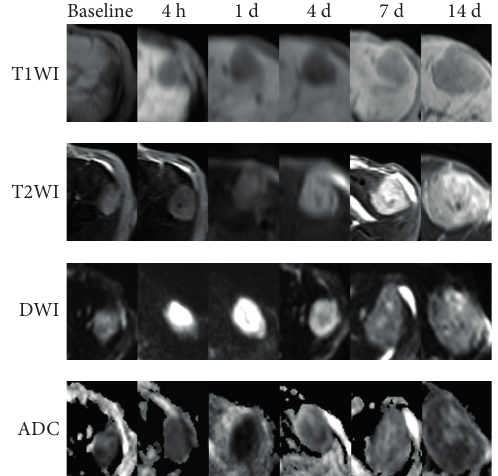
Figure 1: Findings in the M410 group. At all-time points, the tumor was hypointense on T1-weighted imaging (T1WI) and heterogeneously hyperintense on T2-weighted imaging (T2WI). At 4h and 1 day after VDA treatment, the diffused weighted-imaging (DWI) signal of the tumor increased compared with the baseline, and the apparent diffusion coefficient (ADC) values of both the entire tumor and the solid component of the tumor decreased. At 4–14 days after treatment, the DWI signal of the tumor gradually decreased, and the ADC value of the entire tumor gradually in- creased compared with day 1. The ADC value of the solid com- ponent of the tumor first increased on day 4, then gradually decreased on day 7 and day 14 compared with that on day